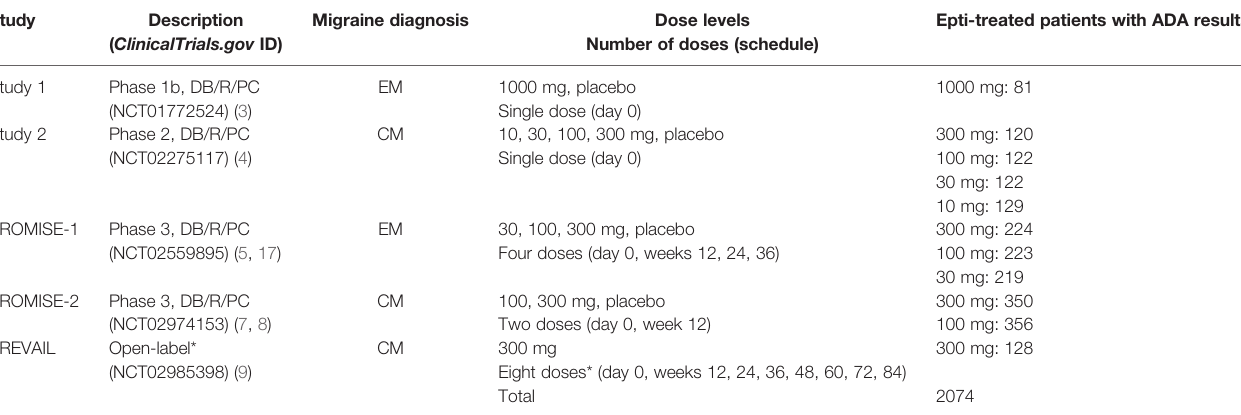
TABLE 1 | Overview of clinical studies contributing to the immunogenicity evaluation for eptinezumab. Study Description Migraine ( ClinicalTrials.gov ID)